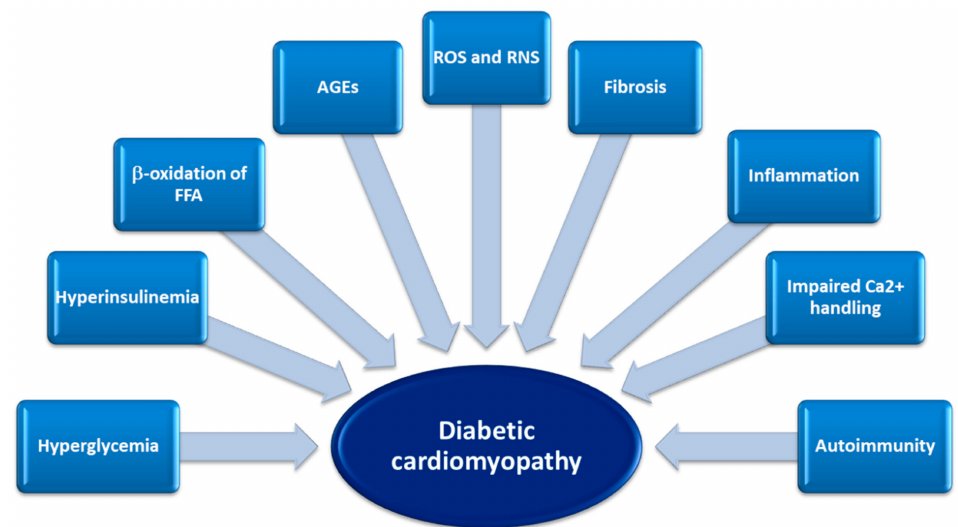
Figure 2. Contributing factors, metabolic derangement and molecular alterations in the development of diabetic cardiomyopathy. FFA: free fatty acids; AGEs: Advanced glycation end products; ROS: reactive oxygen species; RNS: reactive nitrogen